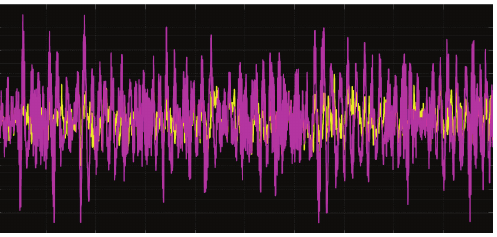
Figure 4: Dynamic travel of the active and passive